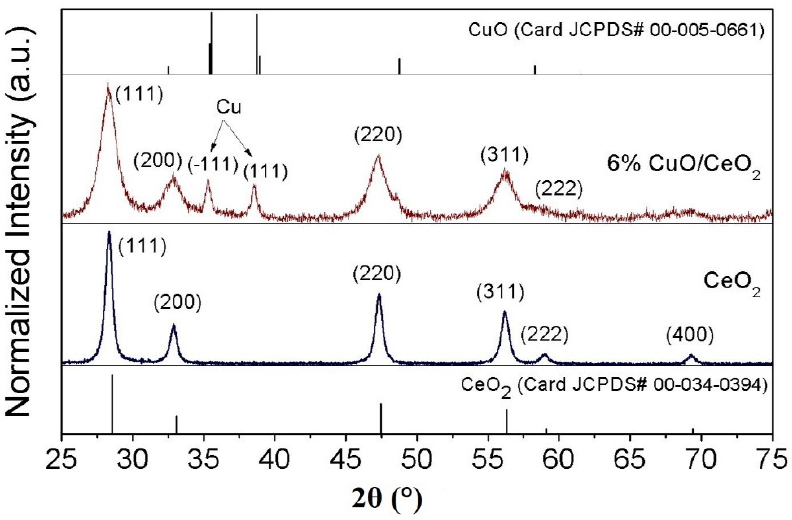
Figure 2. XRD patterns of the CeO 2 and 6% CuO-CeO 2 powders prepared using the solution combustion method compared to reference patterns of CeO 2 and tenorite CuO.